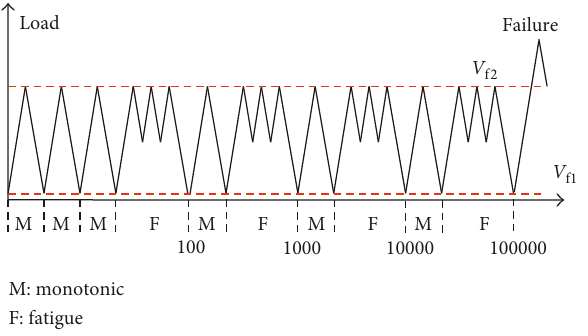
Figure 3: Loading path of fatigue tests.